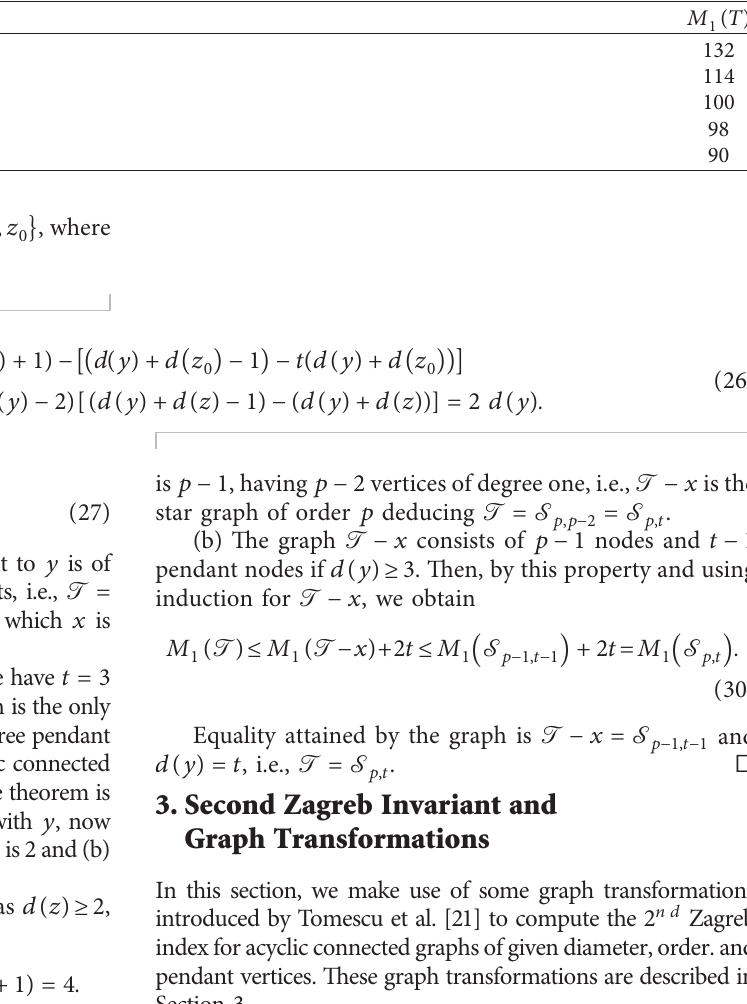
Table 1: First Zagreb invariant for trees of order